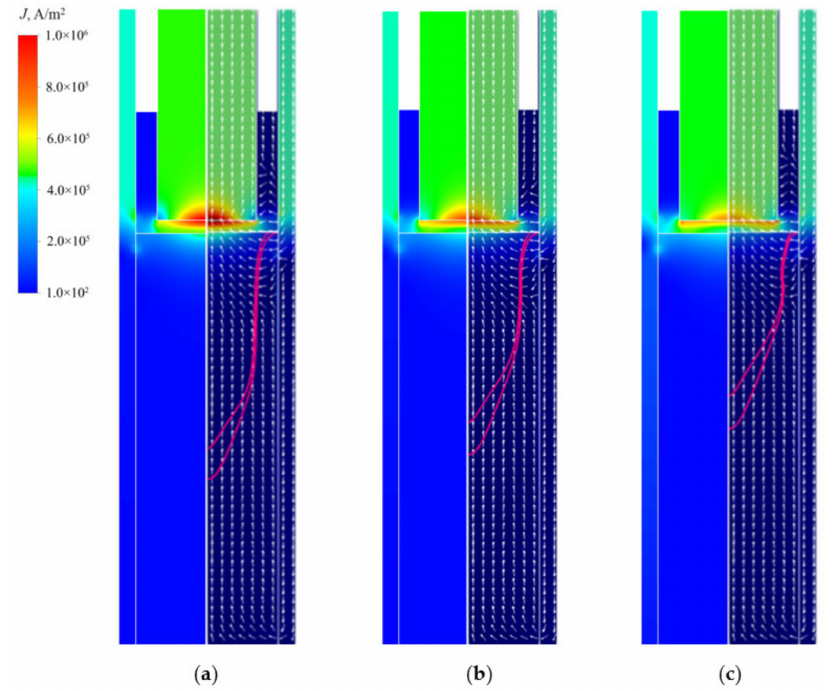
Figure 5. Contour of current density distribution changing with the arc radius when the current of the side arc accounts for 50% from this paper (left half) and the literature [3] (right half): the ratio of arc radius to ingot radius is ( a ) 0.5; ( b ) 0.6; ( c )